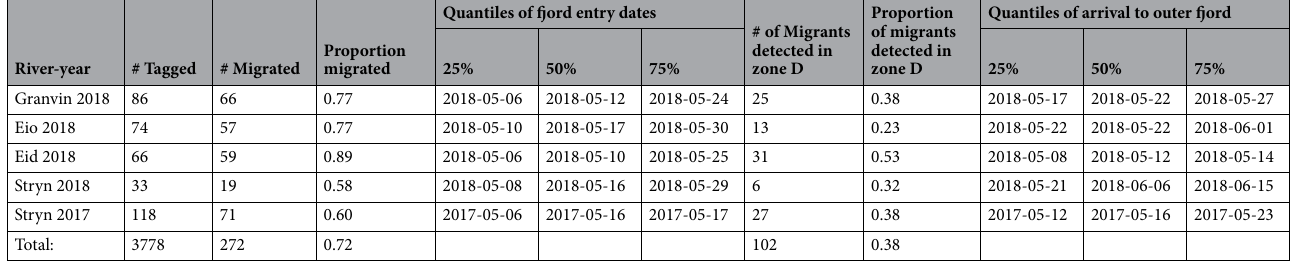
Table 1. Sample sizes and quantiles of fjord entry dates and arrival dates in the outer fjord for each